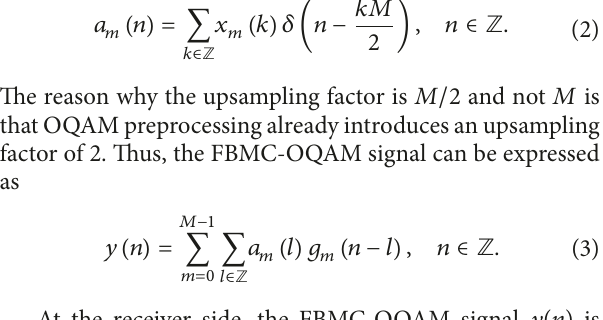
Figure 3: Block diagram of the OQAM demodulation process in a multicarrier system. This diagram performs the inverse operation to the one shown in Figure